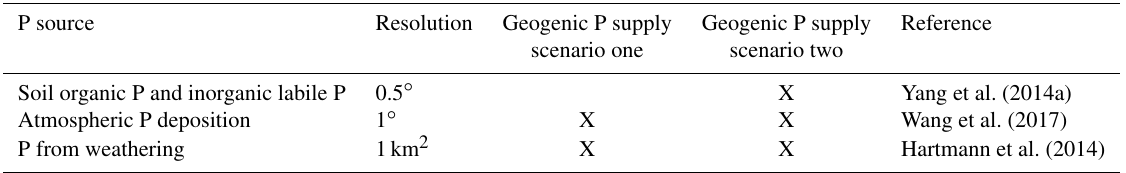
Table 2. Geogenic P sources used for each geogenic P supply scenario. P